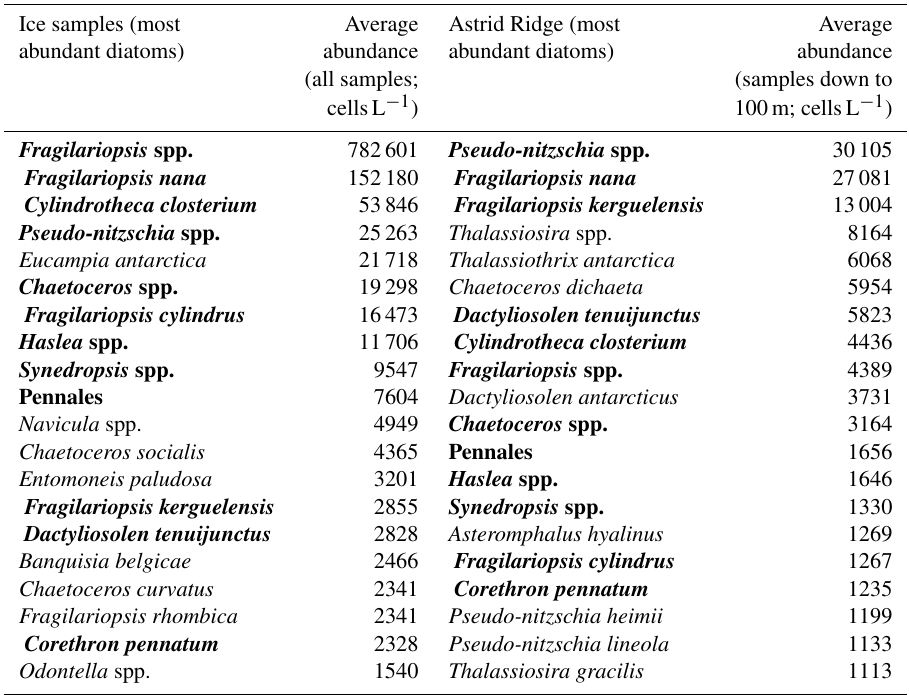
Table B3. Comparison of the 20 most abundant diatom species between sea ice samples and Astrid Ridge samples. Species name in bold text indicates presence in both